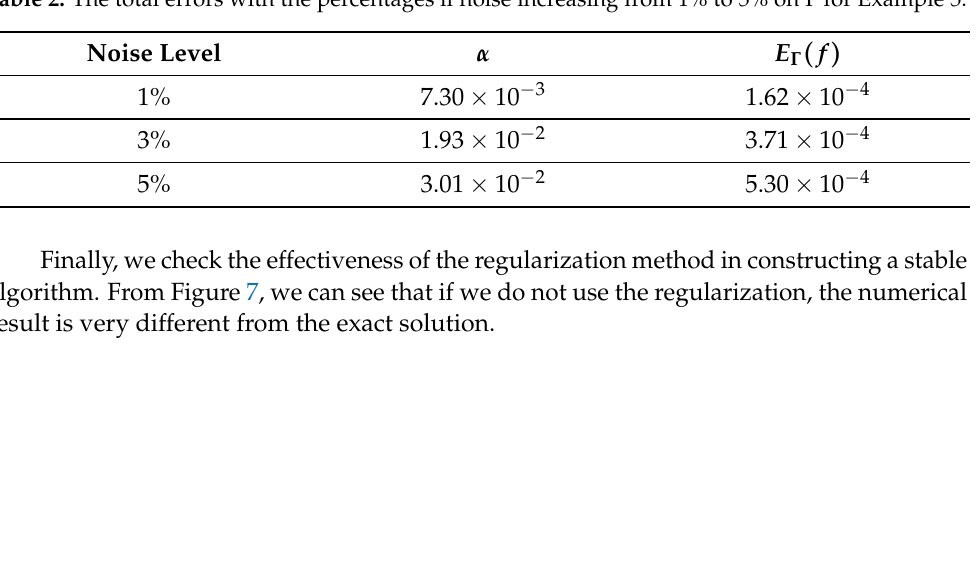
Table 2. The total errors with the percentages if noise increasing from 1% to 5% on Γ for Example